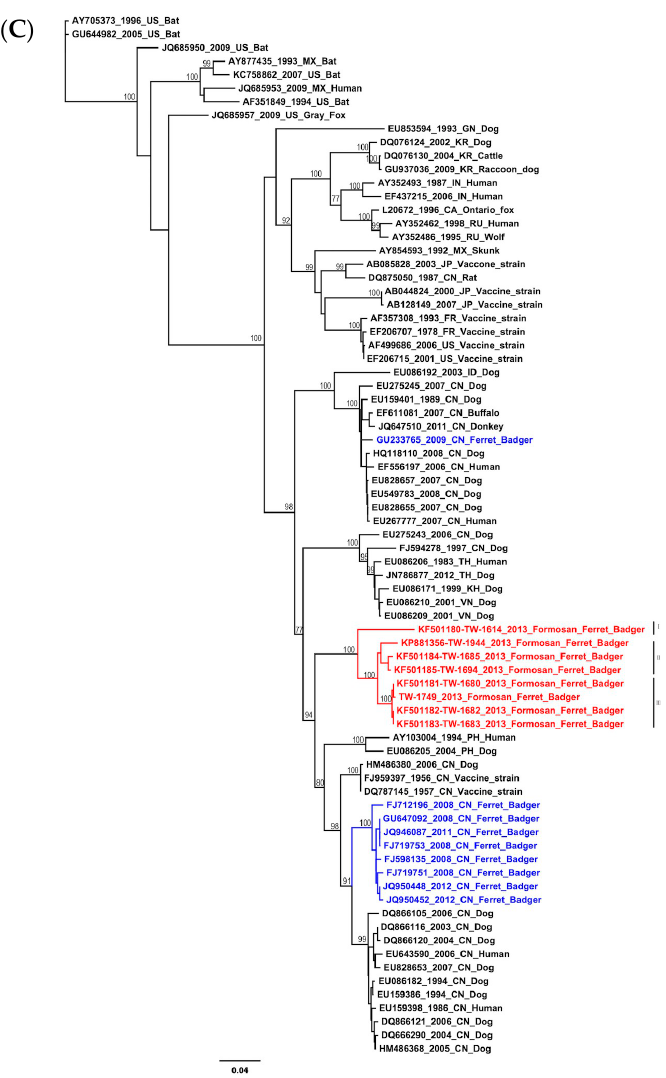
Figure 1. Phylogenetic trees of the rabies virus based on ( A ) glycolprotein, ( B ) matrix, and ( C ) nucleoprotein genes. Tree topology was constructed by the maximum likelihood method. Numbers beside the branches are bootstrap values as percentages (1000 replicates). Texts in red and blue represent the RABV isolated from Formosan and Chinese ferret badgers, respectively.